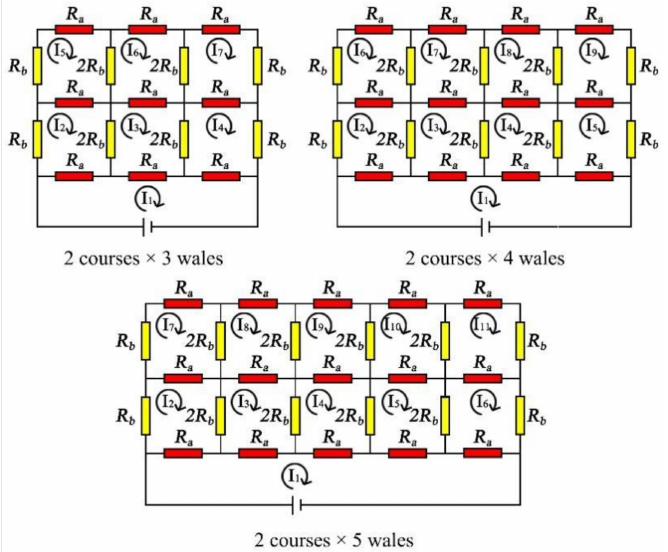
Figure 6. The equivalent resistances of the circuits with 2 courses × 3 wales, 2 courses × 4 wales, and 2 courses × 5